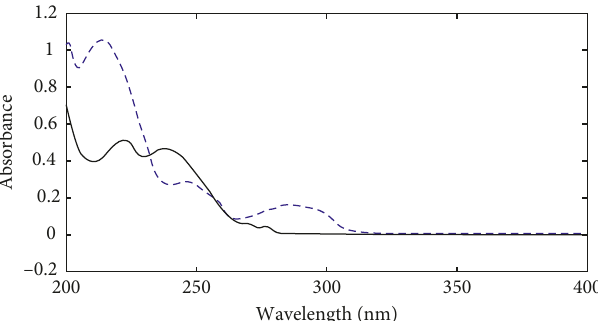
Figure 2: Zero-order absorption spectra of (20 µ g/mL) aclidinium bromide ( ــــــــــ ) and (10 µ g/mL) formoterol fumarate dehydrate